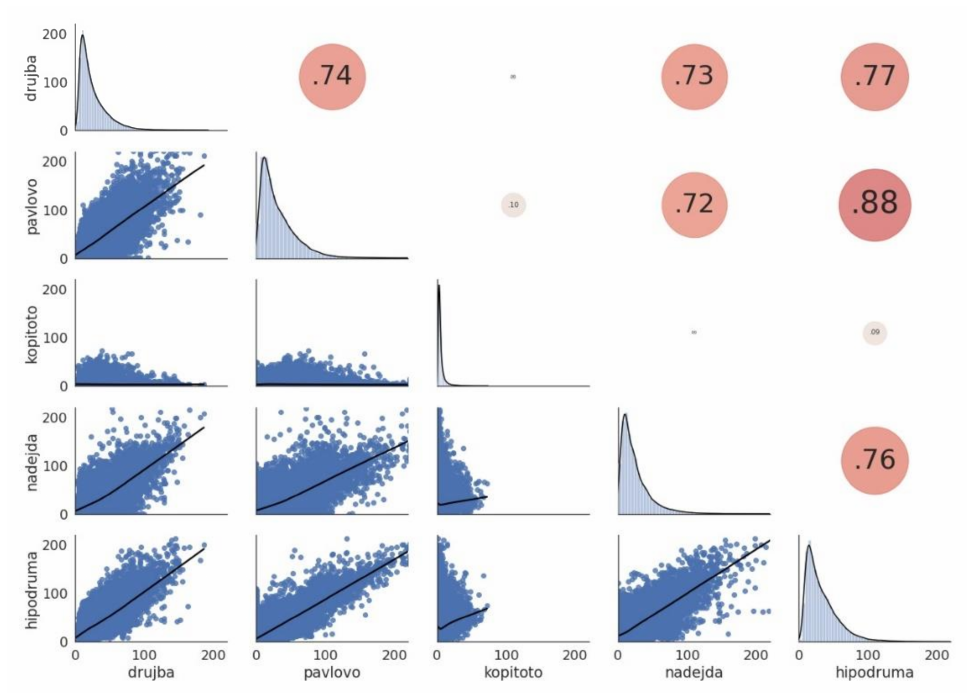
Figure 4. Interaction relationships—scatterplot (lower left triangular area) and Pearson correlation values (upper right triangular area) and histogram (on the diagonal) of the NO 2 at each air quality station measured per